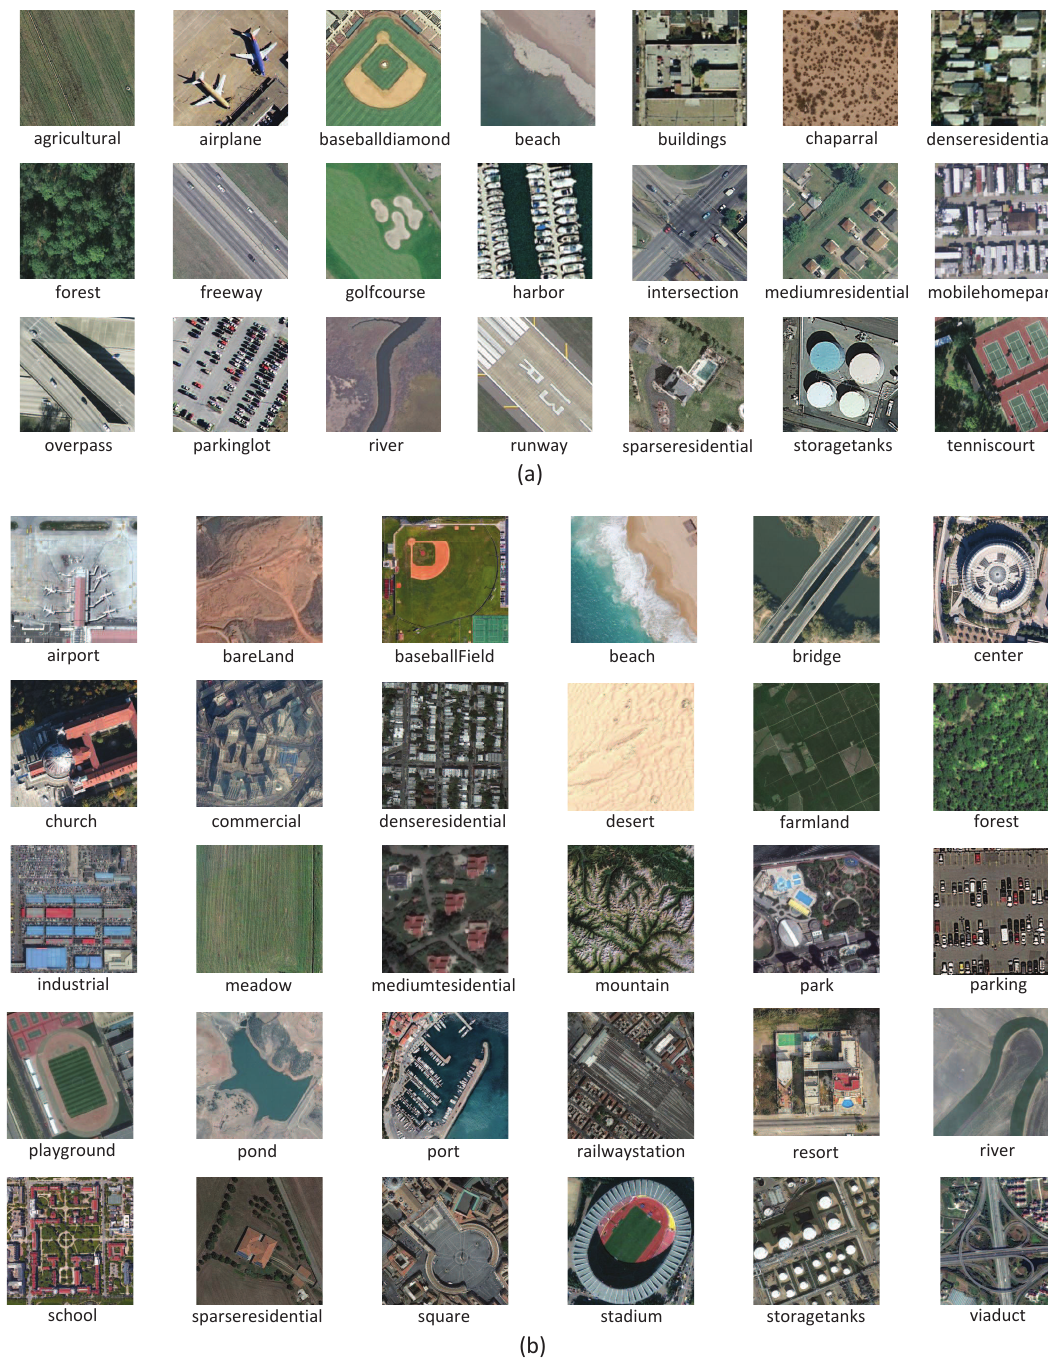
Figure 4. Some sample images from the two datasets: ( a ) UC-Merced Landuse dataset and ( b ) AID